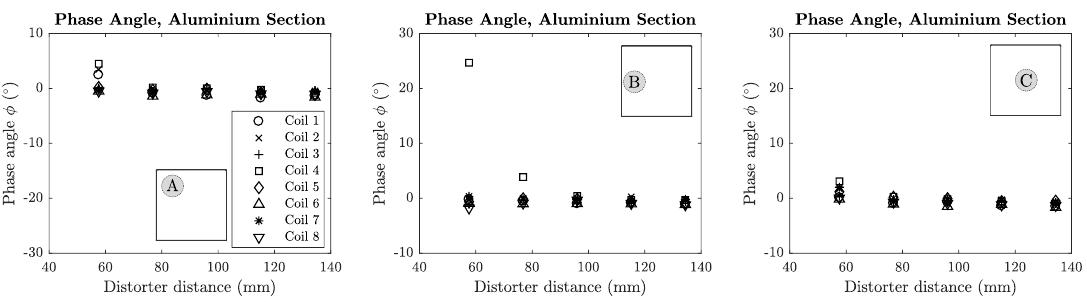
Figure 15. Phase difference plots for small aluminium block distorter in locations A, B and